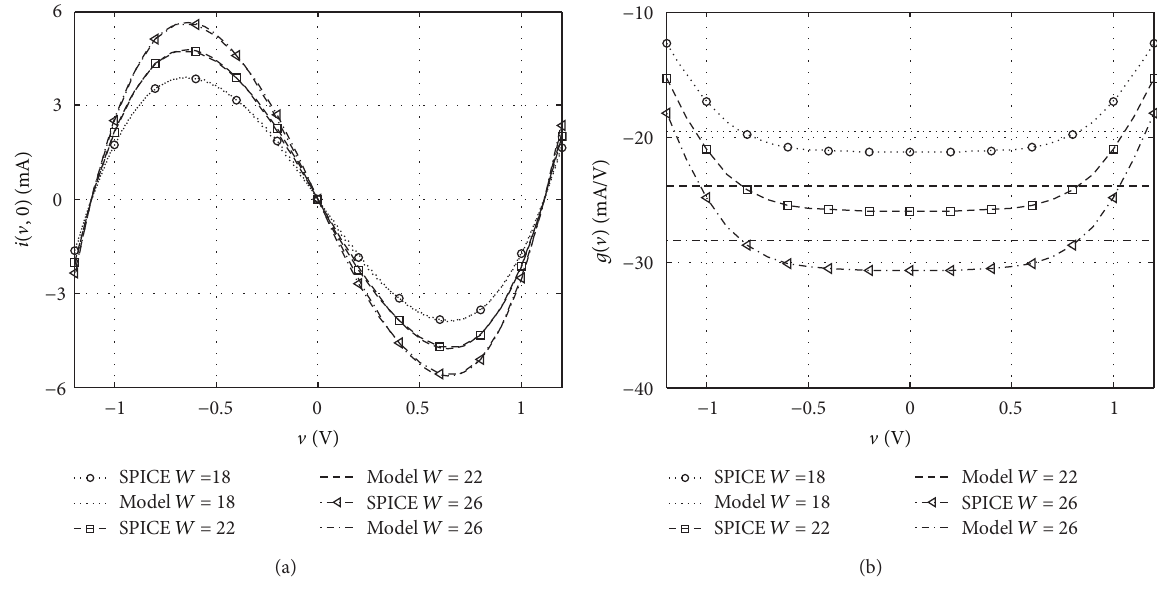
( V ) + 𝑖 ( V ,0) for V = 0 . (b) Voltage- nl in in V + 𝑎 V 3 and 𝑔 ( V ) = 𝑘 1 3 1